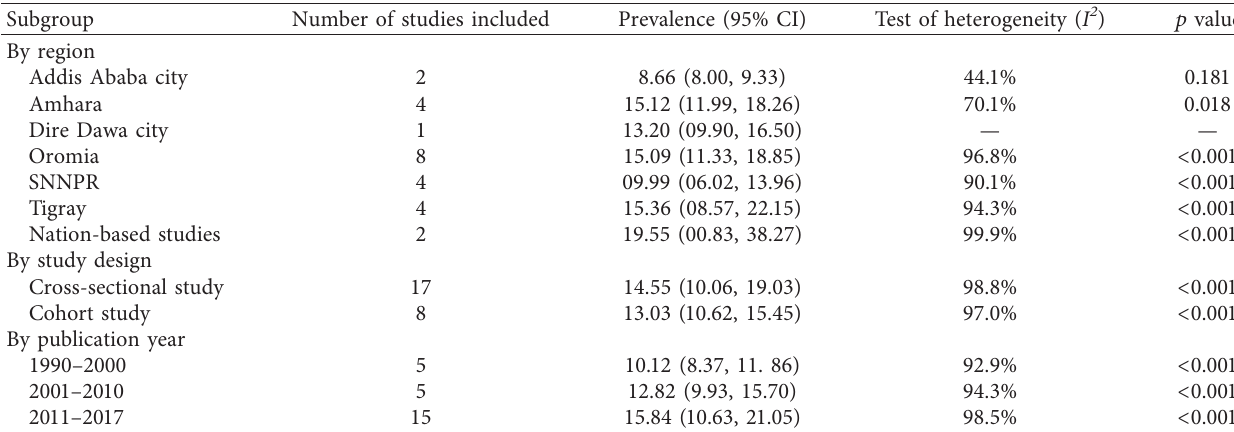
Table 2: Subgroup analysis of prevalence of low birth weight in